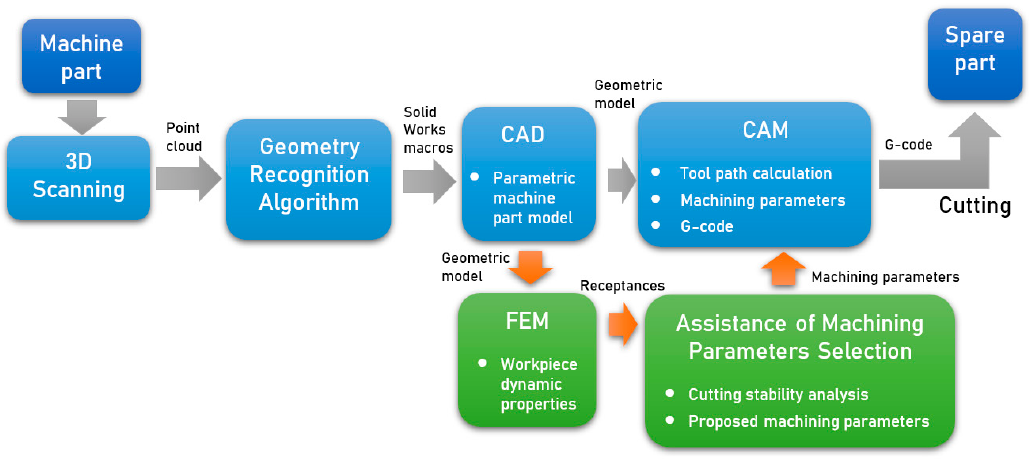
Figure 1. Block diagram showing the system concept.